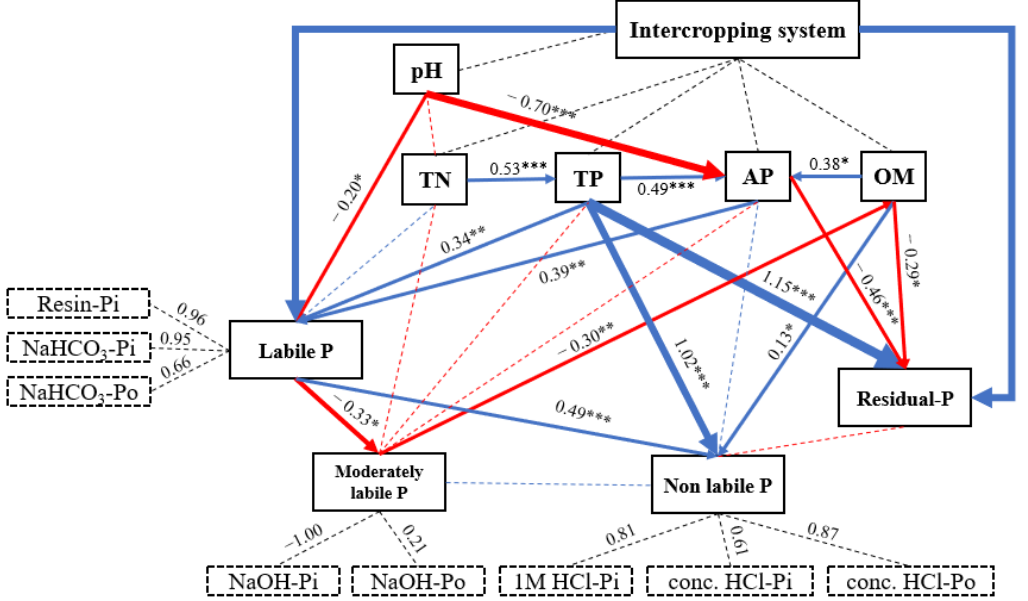
Figure 6. Directed graph of the partial least squares path model (PLS-PM). Note: Each box is an observed (i.e., measured) or latent variable (i.e., constructs). Dashed rectangles indicate the load of the different phosphorus forms. Blue arrows indicate positive effects and wider arrows indicate greater effects, and red arrows indicate negative effects. Dashed lines indicate no significant effect ( p > 0.05). The number of asterisks in the upper right of the number indicates the degree of influence: * p < 0.05, ** p < 0.01, *** p < 0.001. The model is assessed using the Goodness of Fit (GoF) statistic, and the GoF value was 0.59.